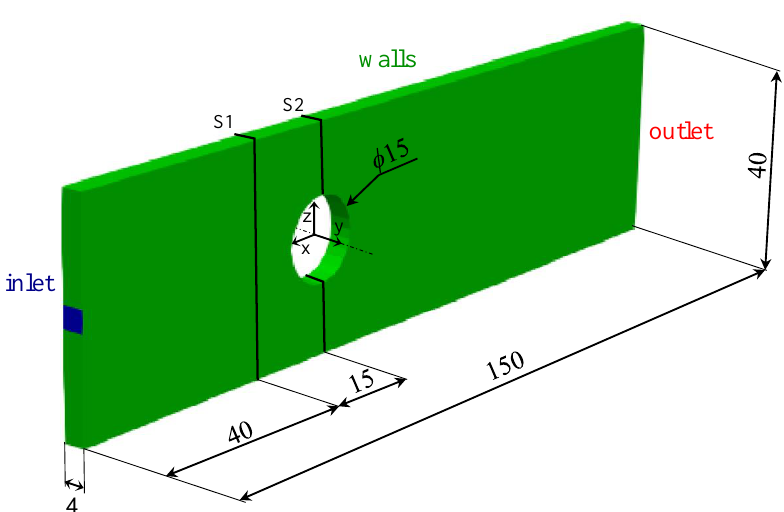
Figure 4. Geometry and boundary patches for Case Study 2 (dimensions in mm). S1 and S2 denotes Slice 1 and Slice 2,